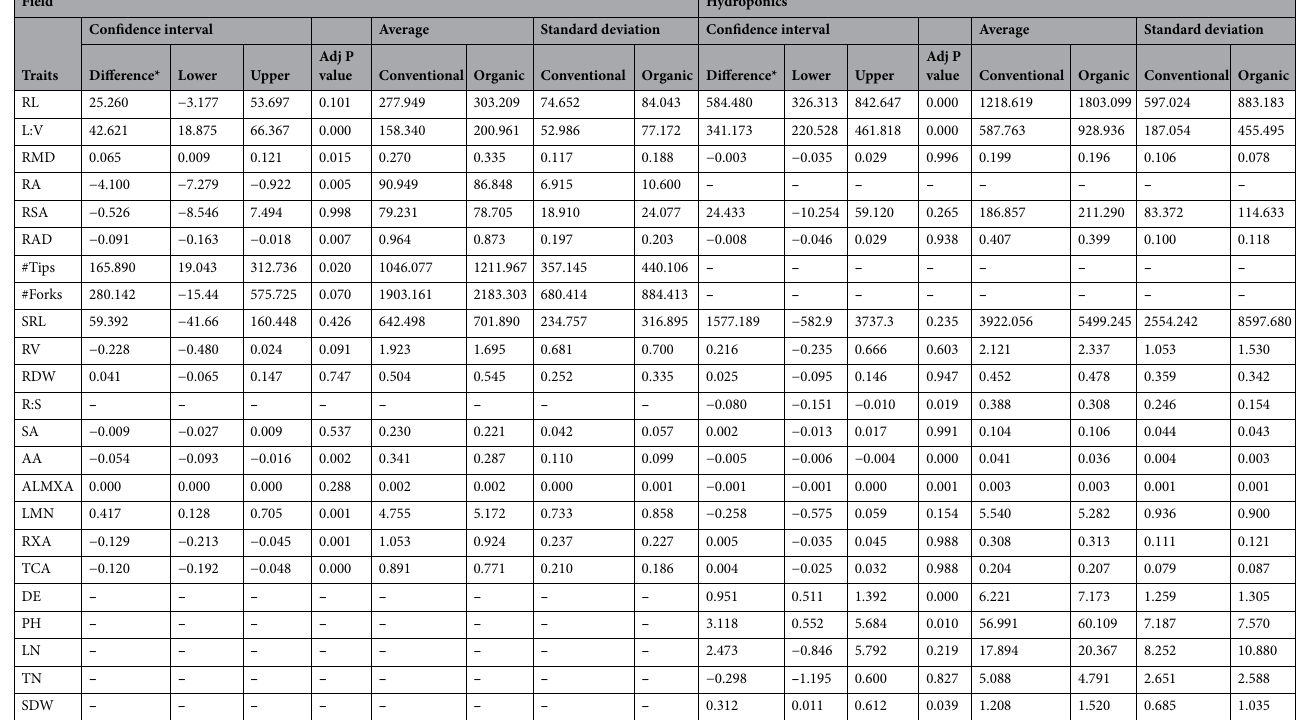
Table 2. Comparison of organic and conventional population root phenotypes under field and hydroponic evaluation. Tukey HSD pairwise comparison for root morphology, anatomy and shoot-related traits at 95% confidence level showing the difference between group means (second column) and the adjusted p -value (fifth column) for all root traits (first column) between the two groups of barley offspring lines. Besides, the average value and standard deviation of the values for ISR42-8 and Golf are illustrated. The stable is split in two main windows—one for field, the other for hydroponic experiment. *Organic always as first value—negative values are related to smaller in organic lines. See Table 1 for trait